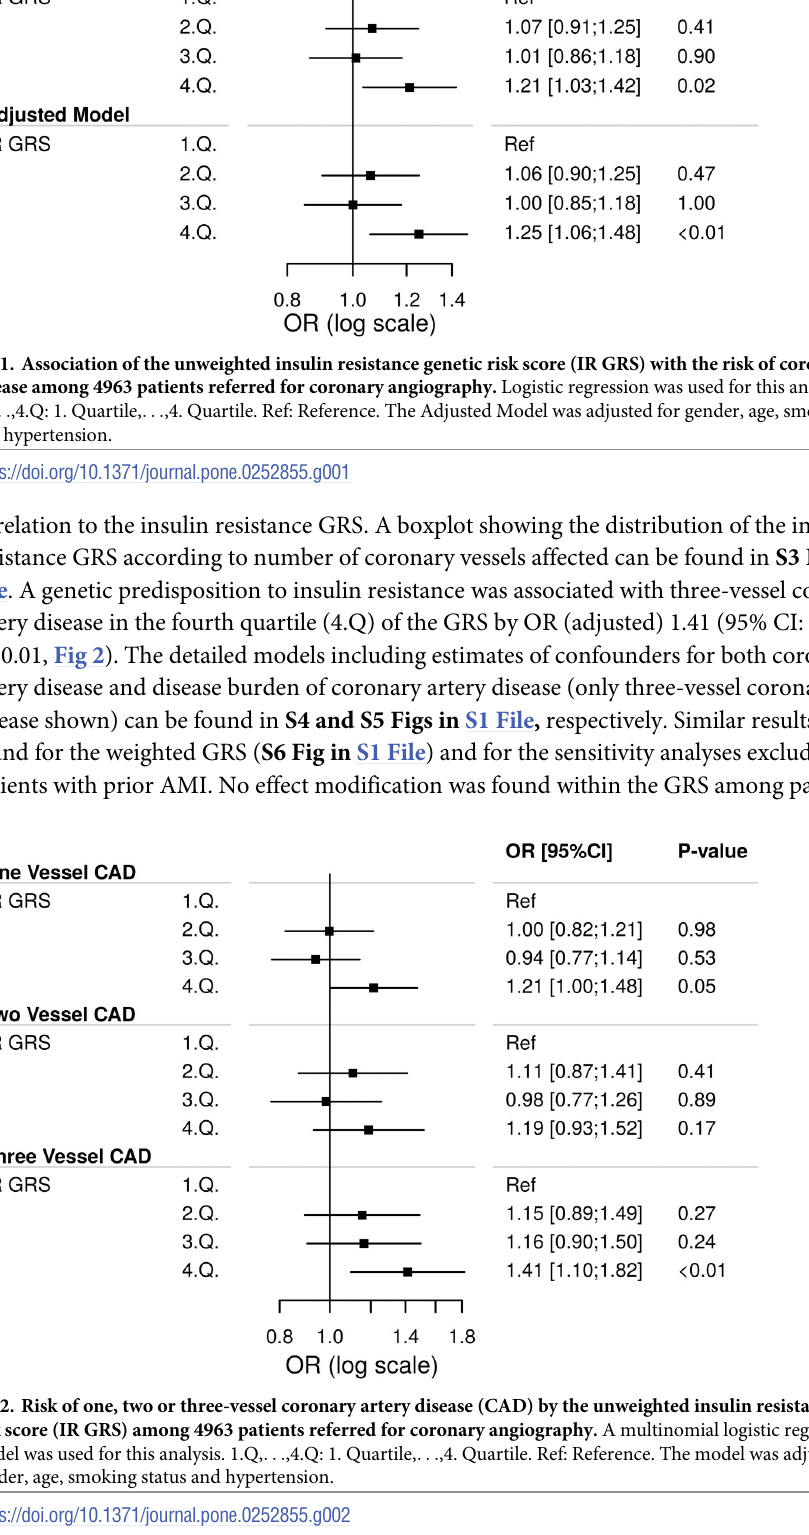
Fig 2. Risk of one, two or three-vessel coronary artery disease (CAD) by the unweighted insulin resistance genetic risk score (IR GRS) among 4963 patients referred for coronary angiography. A multinomial logistic regression model was used for this analysis. 1.Q, ... ,4.Q: 1. Quartile, ... ,4. Quartile. Ref: Reference. The model was adjusted for gender, age, smoking status and